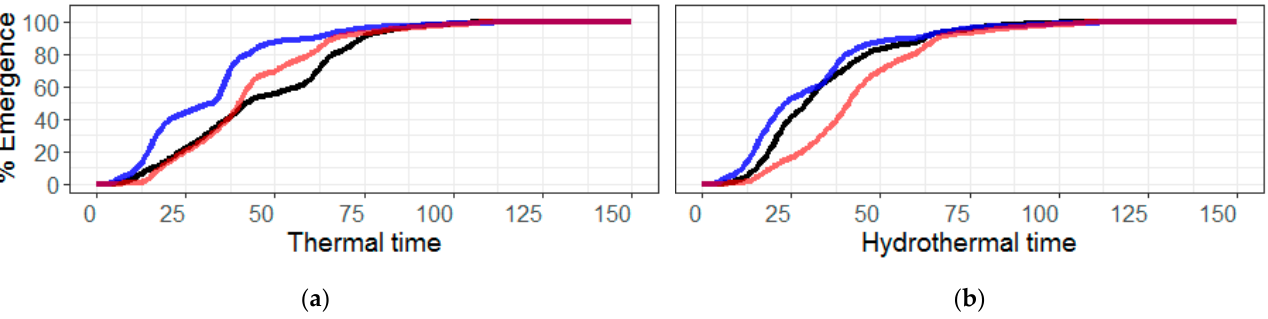
Figure 4. Representation of non-parametric thermal ( a ) and hydrothermal ( b ) time models for Phalaris brachystachys (red), Phalaris minor (blue) and Phalaris paradoxa (black).